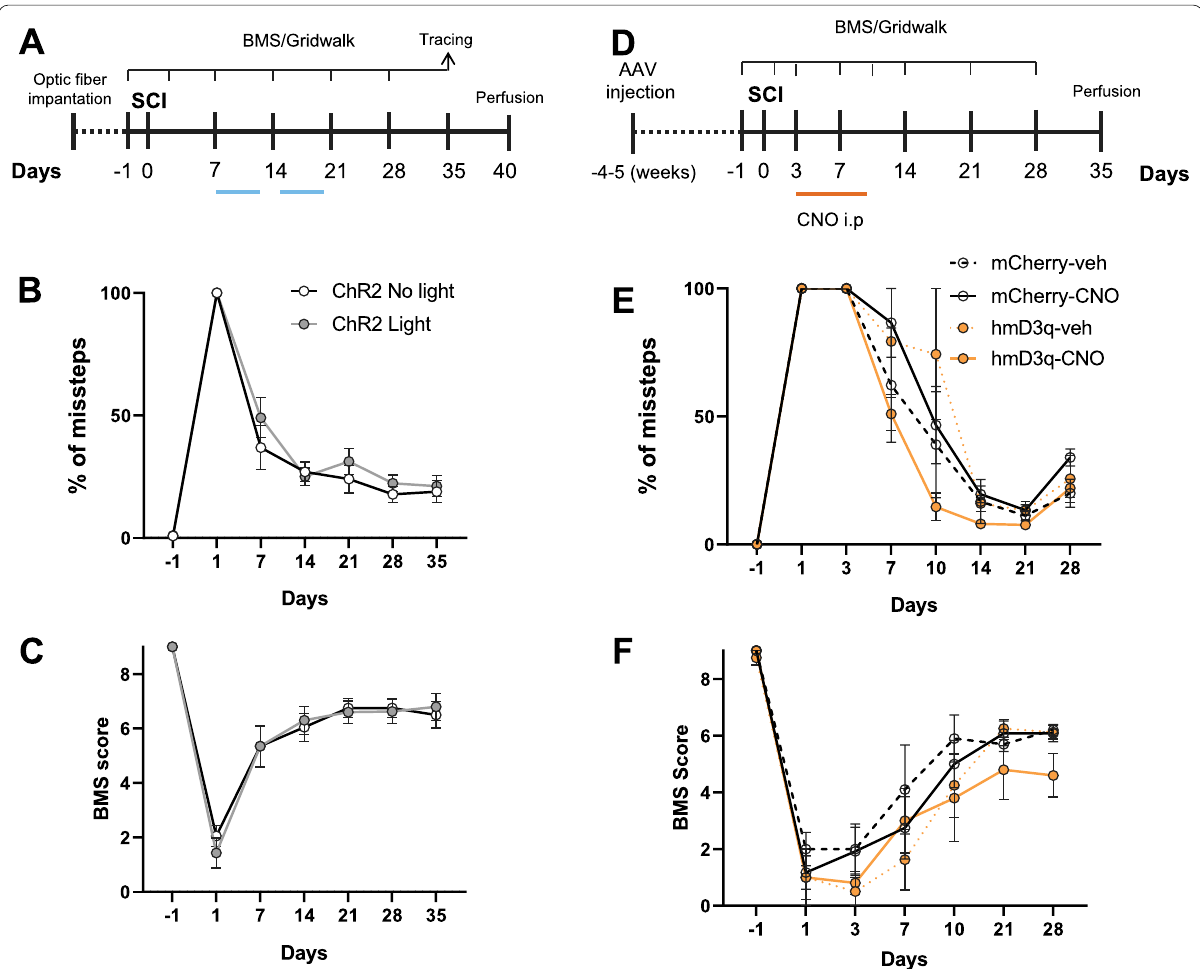
Fig. 5 Increasing neuronal activity does not induce recovery after CNS injury. A Timeline of the CST injury and stimulation experiments. B , C % of missteps in the gridwalk test ( B ) (n 8–9 mice per group for each timepoint) and BMS score ( C ) (n = differences in sensorimotor recovery in stimulated Thy1‑ChR2 (ChR2 Light) mice when compared to non‑stimulated (ChR2 No light) after CST injury. D Timeline of the DCA and stimulation experiments. E , F Chemogenetically stimulated animals (hM3Dq‑CNO) show similar sensorimotor function recovery to non‑stimulated ones (mCherry‑CNO, mCherry‑veh, hM3Dq‑veh) after DCA as seen by the gridwalk ( E ) (n timepoint) and BMS ( F ) (n 5–6 mice per group for each timepoint) tests. Represented data correspond to the BMS score and % of missteps in the = gridwalk. Data are expressed as mean s.e.m. ANOVA followed by Bonferroni ±